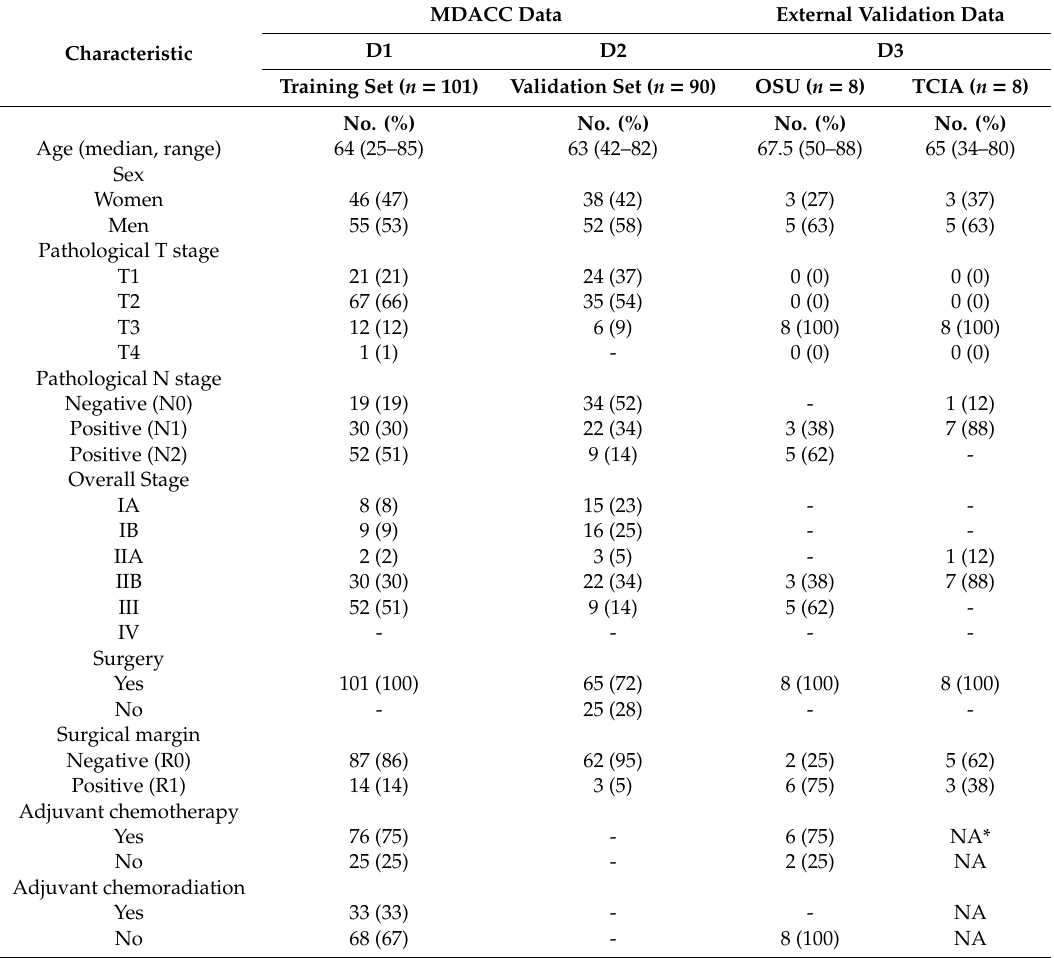
Table 1. Patients’ characteristics obtained from the MD Anderson Cancer Center (MDACC) data sets and the external validation data sets from Ohio State University (OSU) and The Cancer Imaging Archive